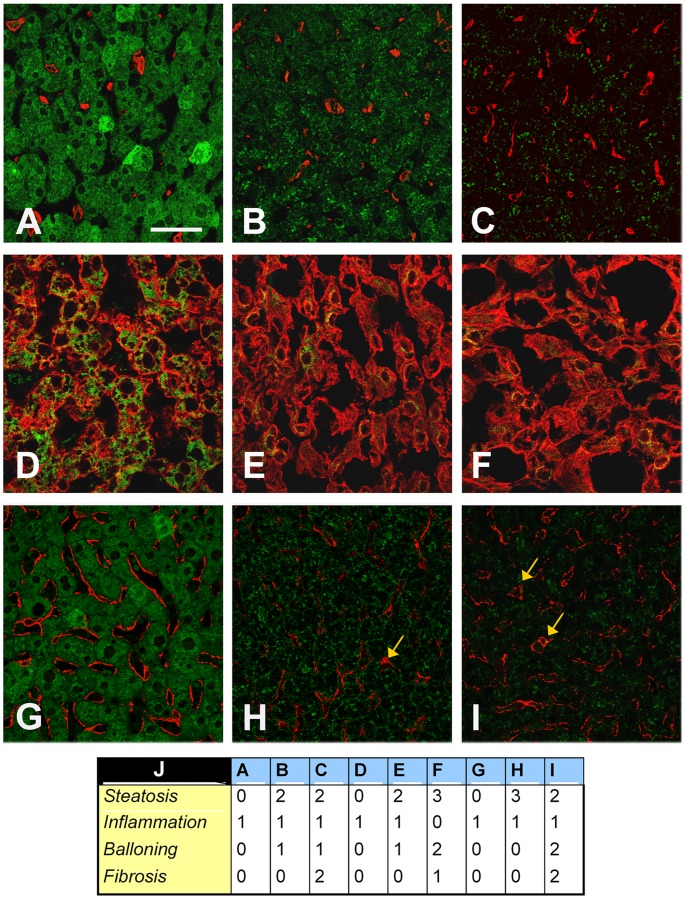
Representative confocal immunofluorescence of Klotho co-receptor localization in liver tissues.The representative confocal immunofluorescence was performed on liver tissue cryostat sections OCT-embedded. (A–C) Co-staining of Klotho co-receptor (green) and CD163 (red) in children without NAFLD (A), with NAFLD NASH− (B) and with NASH+ (C). (D–F) Co-staining of Klotho co-receptor (green) and cytokeratin 8/18 (red) in children without NAFLD (D), with NAFLD NASH− (E) and with NASH+ (F). (G–I) Co-staining of Klotho co-receptor (green) and alpha-SMA (red) in children without NAFLD (G), with NAFLD NASH− (H) and with NASH+ (I). Yellow arrows indicate hepatic stellate cells. The white bar represents a 30 µm length. (J) Histological scores for panels from A to I.